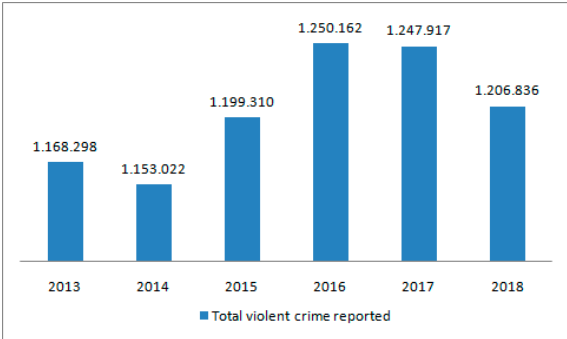
Figure 1. Total violent crime reported in the United States (in millions). Survey period: 2013–2018. Publication date: September 2019. Source: statista.com.